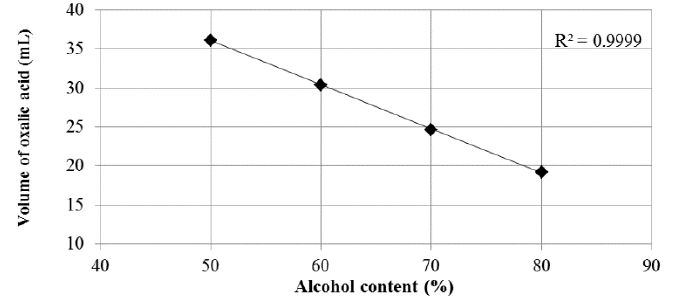
Figure 2 : The plot of the number of drops of oxalic acid versus the percentage of alcohol in the aqueous samples. The error bars represent the standard deviation of the volume for